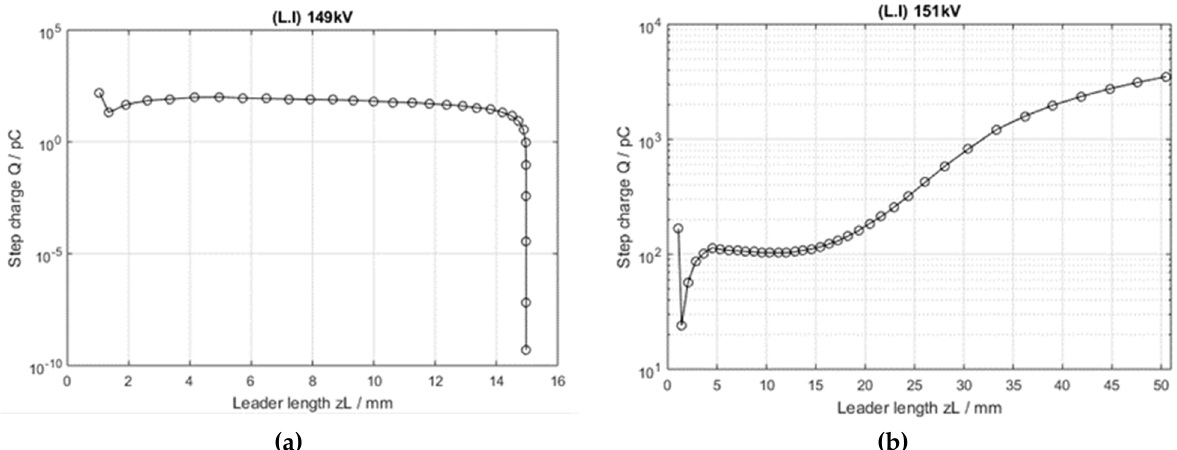
Figure 6. ( a ) Arrested leader for 50 mm gap with 10 mm particle at 149 kV (LI), P = 0.4 MPa; ( b ) breakdown leader for 50 mm gap with 10 mm particle at 151 kV (LI), P = 0.4 MPa.